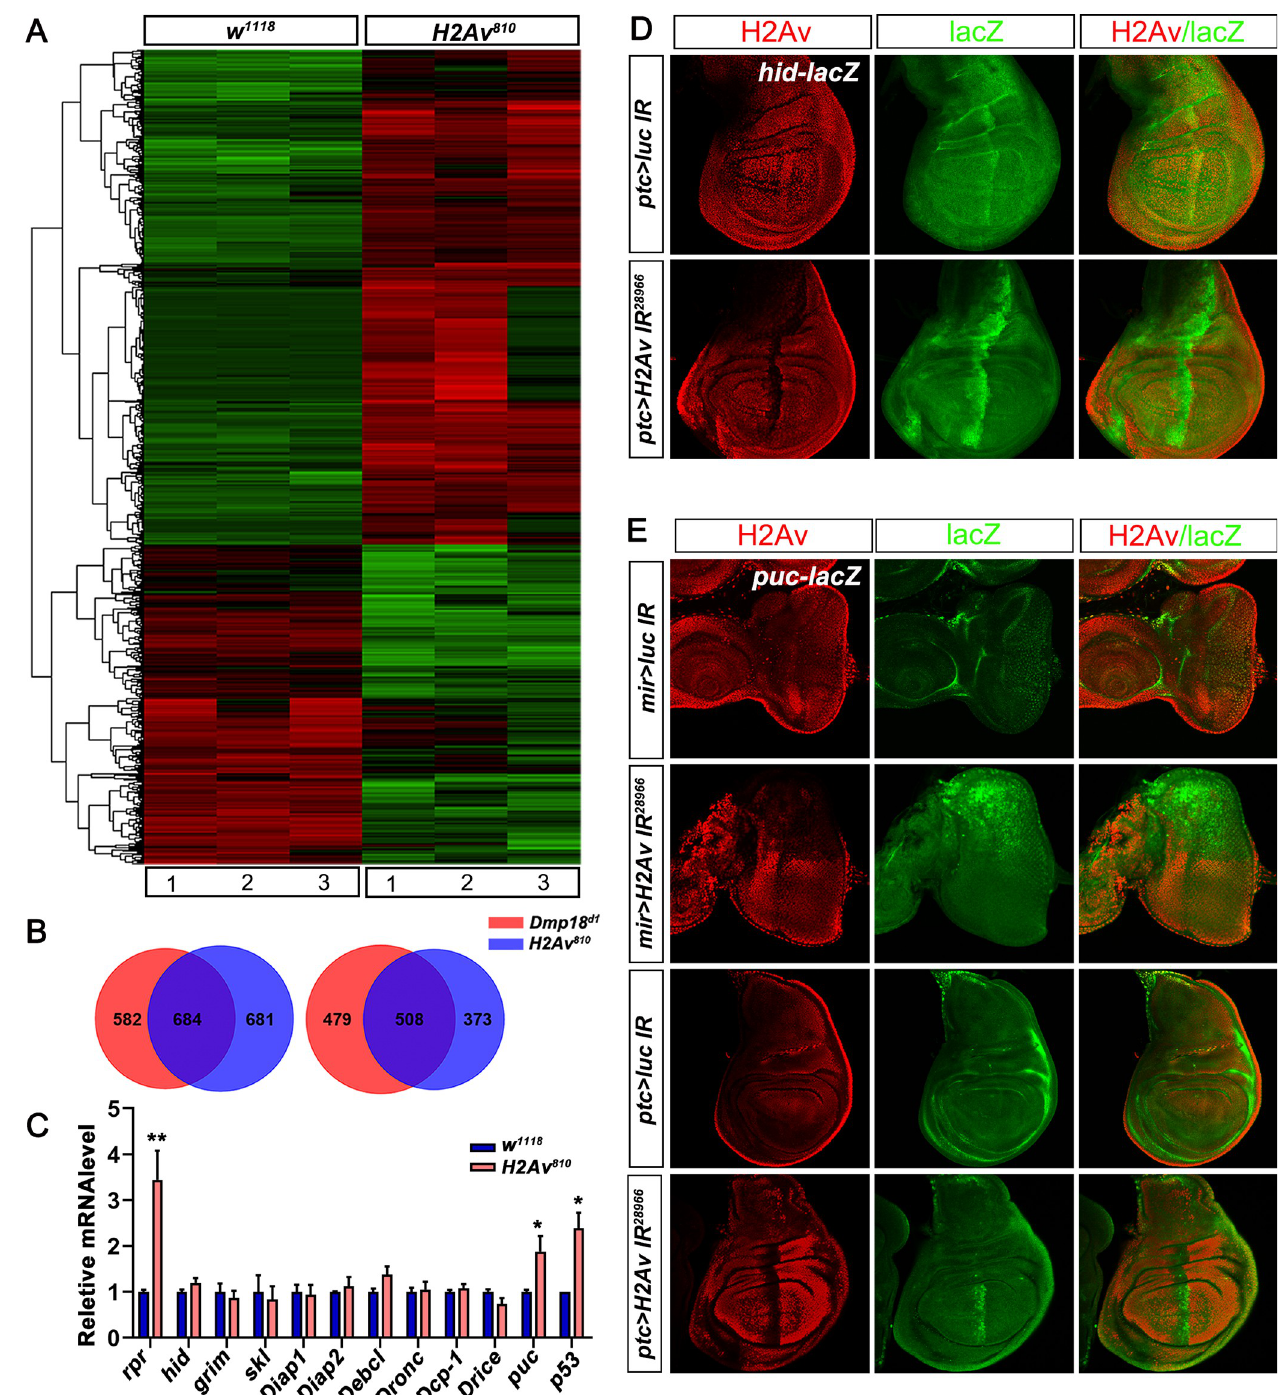
Fig 6. H2Av regulates the transcription of apoptotic genes. (A) Clustered heatmap of log2-transformed FPKMs showed the differentially expressed genes in homozygous H2Av 810 . (B) Venn diagram showed the overlap of differentially expressed genes in Dmp18 d1 and H2Av 810 . (C) RT-qPCR analysis showed the expression changes of apoptotic-related genes in homozygous H2Av 810 . � p < 0.05 and �� p < 0.01. (D) Knockdown of H2Av by ptc-gal4 increased hid-lacZ expression. (E) Knockdown of H2Av by mirr-gal4 or ptc-gal4 increased puc-lacZ expression. Genotypes: D: ptc-gal4/+; UAS-luciferase IR/hid-lacZ and ptc-gal4/ +; UAS-H2Av IR 28966 /hid-lacZ . E: mirror-gal4 , puc-lacZ/UAS-luciferase IR , mirror-gal4 , puc-lacZ/UAS-H2Av IR 28966 , ptc-gal4/+; UAS-luciferase IR/puc-lacZ and ptc-gal4/+; UAS-H2Av IR 28966 /puc-lacZ .